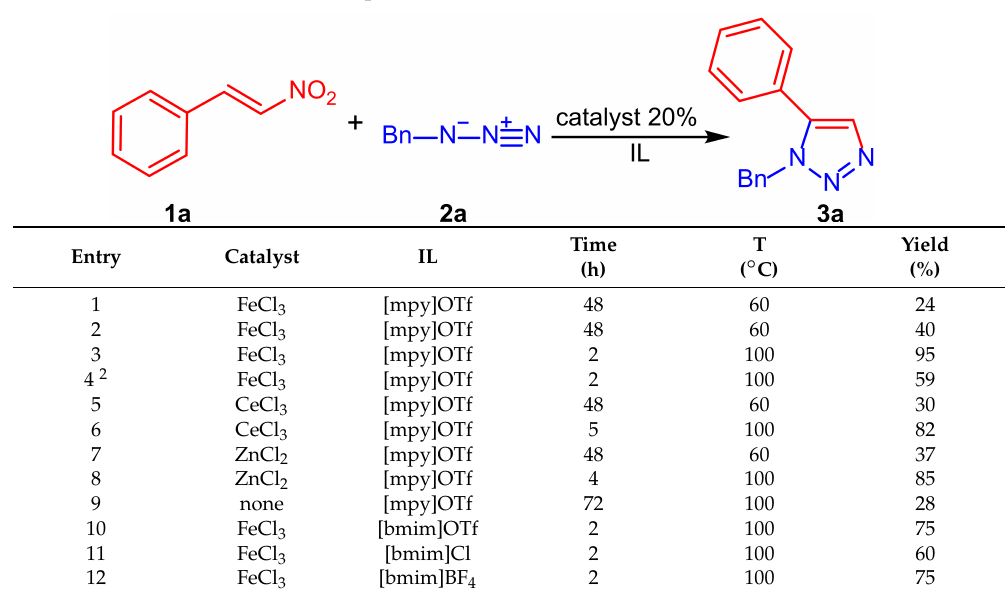
Table 1. Optimization of reaction conditions 1